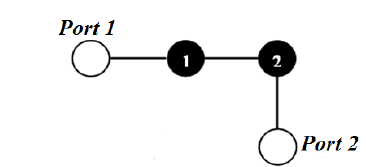
FIGURE 6. Schematic of the resonators 1 and 2 in step two.